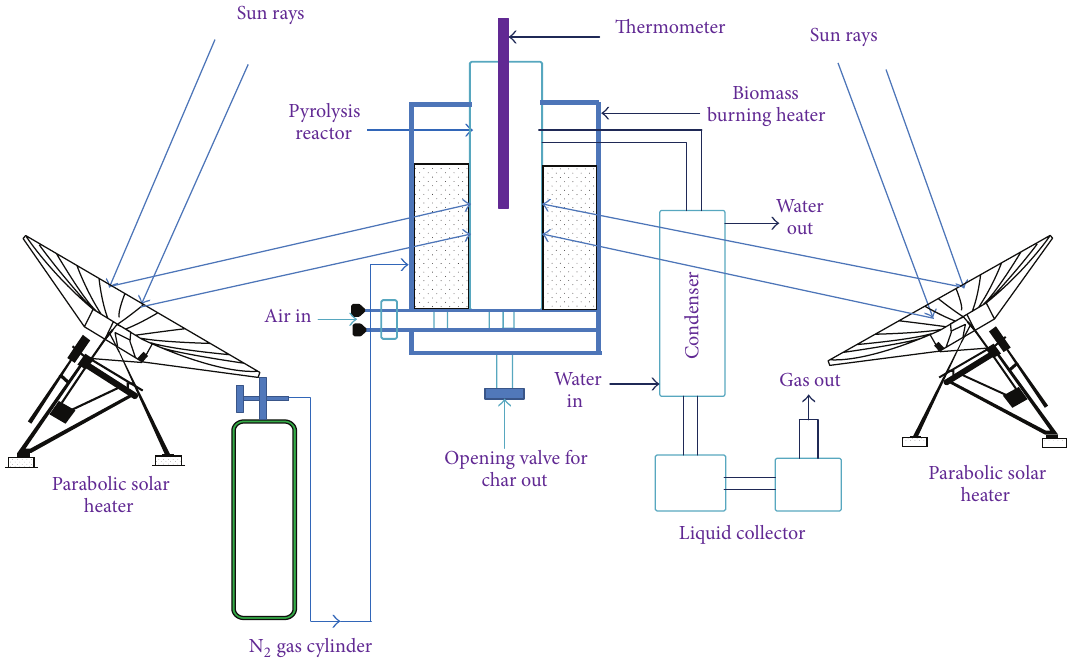
Figure 5: Schematic diagram of fixed bed solar assisted pyrolysis system.